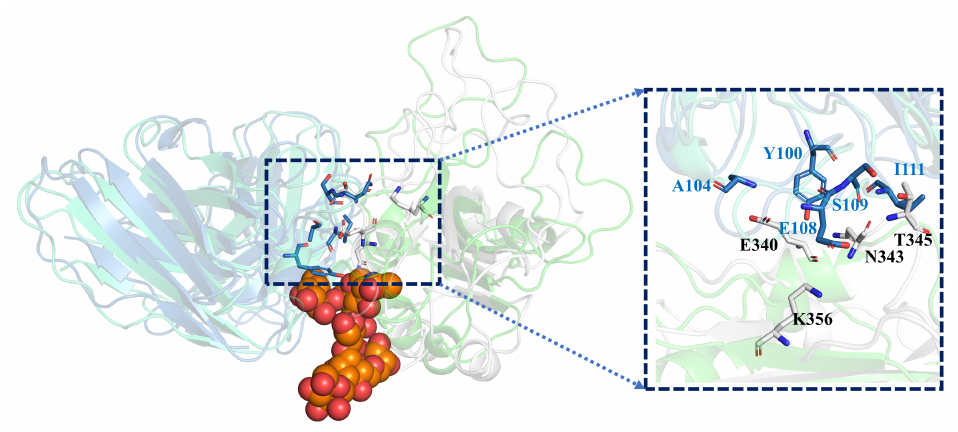
Figure 7. The wedge effect of polysaccharide: gray for GLYCAN antigen RBD; skyblue for GLYCAN antibody S309; green for NO-GLYCAN antigen RBD; blue-green for NO-GLYCAN antibody S309; orange for GLYCAN system of polysaccharide; boxes are antigen–antibody binding